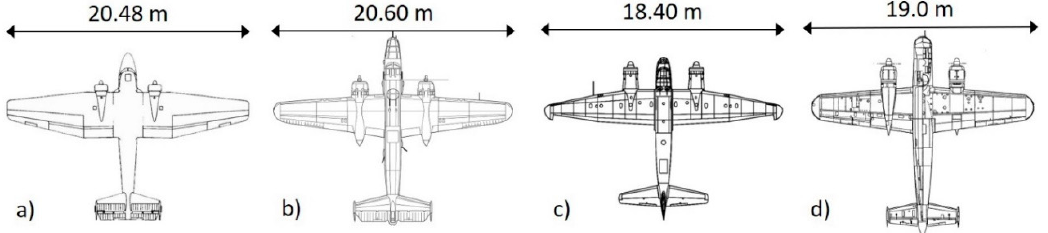
Figure 11. Four types of aircraft selected in the first phase of identification: ( a ) Szcze-2 aircraft; ( b ) B-25 Mitchell aircraft; ( c ) Junkers Ju-88 aircraft; ( d ) Dornier Do 217 aircraft.